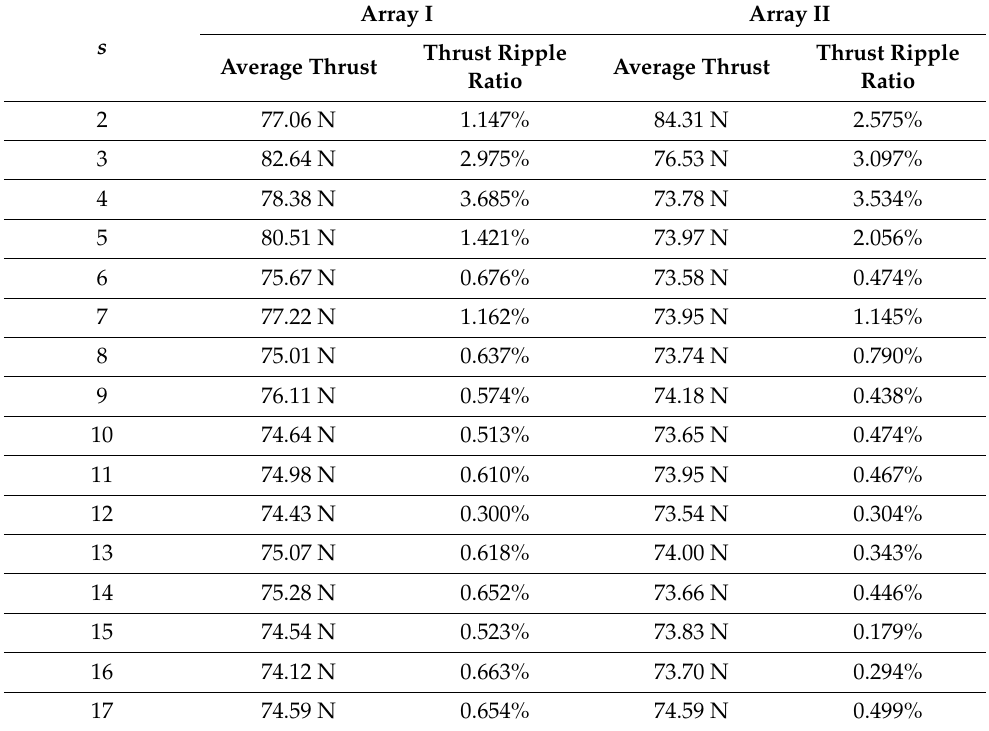
Table 5. Comparison of thrust characteristics of PMLSMs with two PM width-modulation